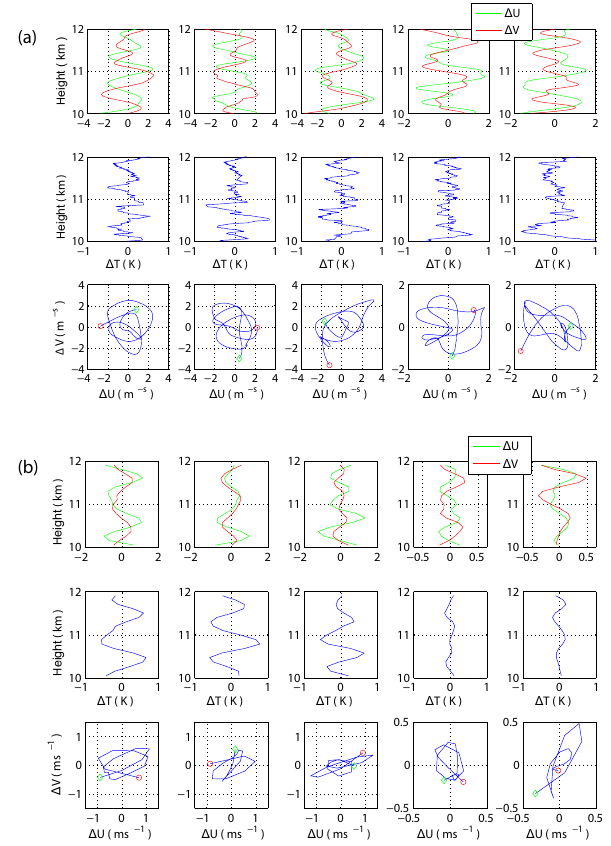
Figure 9. (a) Vertical profile of wind ( U,V ) and temperature ( T ) fluctuations from the five radiosondes in Fig. 1, and corresponding hodographs for the wind fluctuations between 10 and 12km heights. (b) Vertical profile of wind ( U,V ) and temperature ( T ) fluctuations from the WRF data experiment corresponding to the five radioson- des in Fig. 1, and corresponding hodographs for the wind fluctua- tions between 10 and 12km heights. The lowest height (10km) of the hodograph is marked by a red circle, the highest (12km) by a green